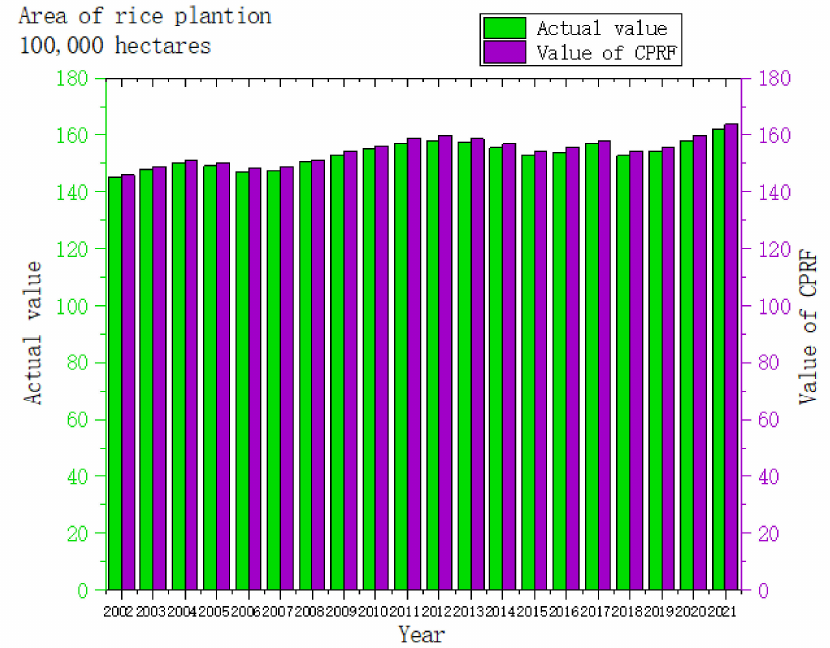
Figure 5. Planting area comparison of actual value and CPRF prediction in 20 years.